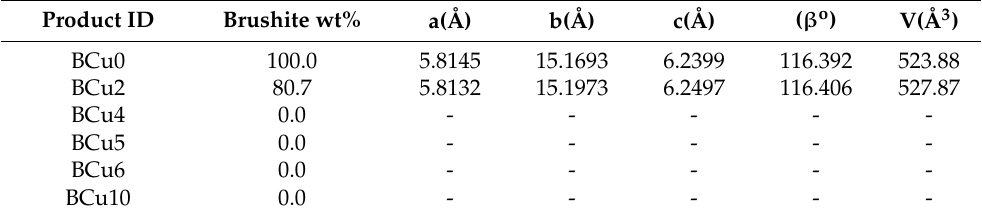
Table 2. The parameters of unit cell for brushite from XRD data (Rietveld refinement).